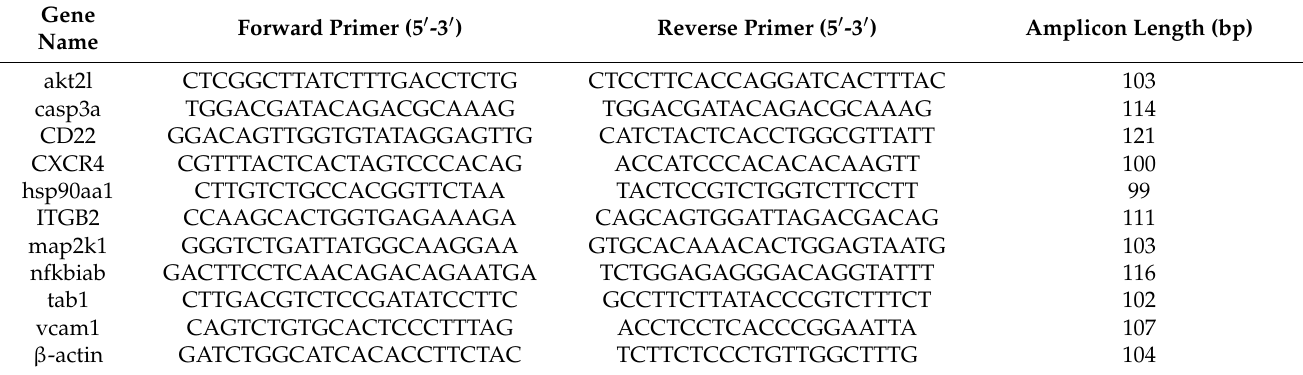
Table 1. Primers used for quantitative RT-PCR